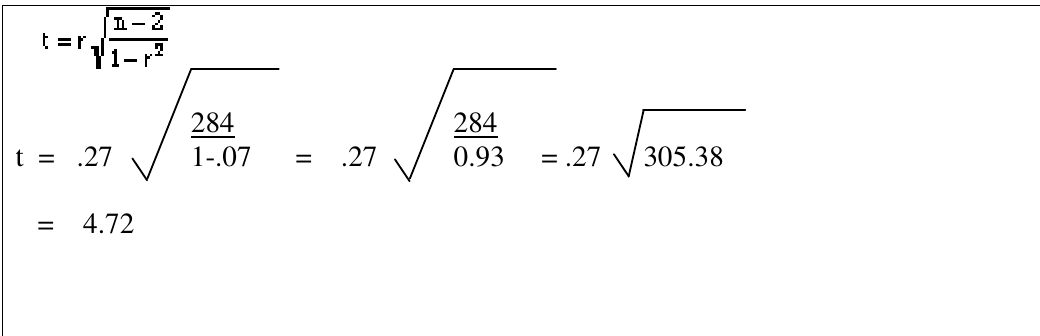
284 284 t = .27 1-.07 = .27 0.93 = .27 305.38 = 4.72